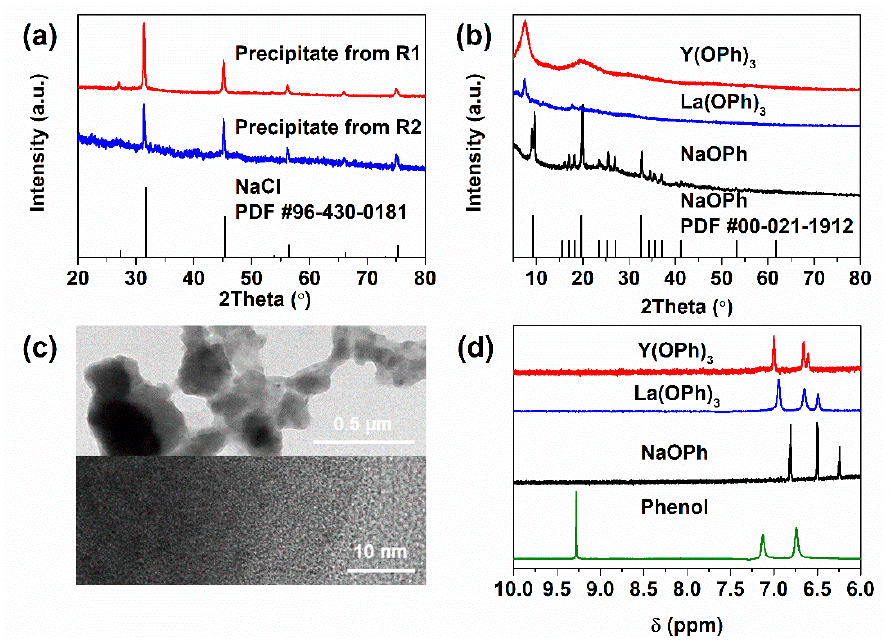
Figure 2. ( a ) The XRD patterns of the precipitates from R1 and R2. ( b ) The XRD patterns of Y(OPh) 3 and La(OPh) 3 compared with NaOPh. ( c ) Morphologies of Y(OPh) 3 observed by TEM. ( d ) 1 H NMR spectra of Y(OPh) 3 and La(OPh) 3 compared with NaOPh and phenol, respectively. NMR was employed to characterize the two samples in comparison with phenol and sodium phenoxide. It was shown that signals of both Y(OPh) 3 and La(OPh) 3 in 1 H NMR shifted downfield compared with NaOPh, confirming the formation of new compounds.